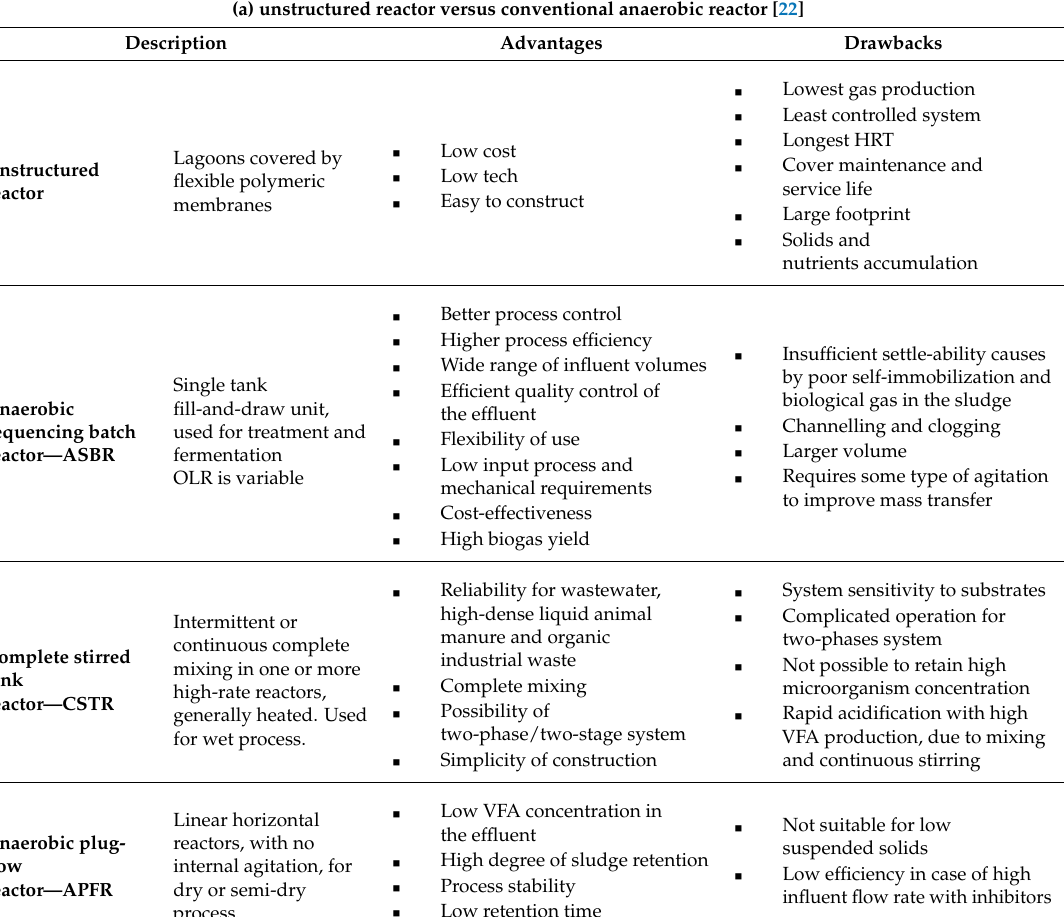
Table 2. Comparison among different digester